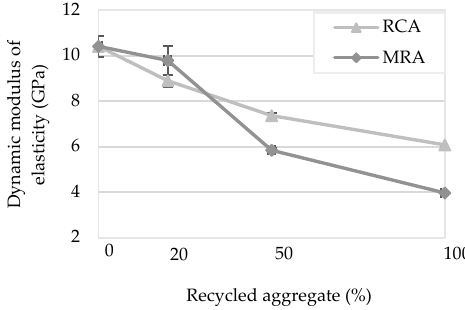
Figure 3. Dynamic modulus of elasticity of the mortars tested.